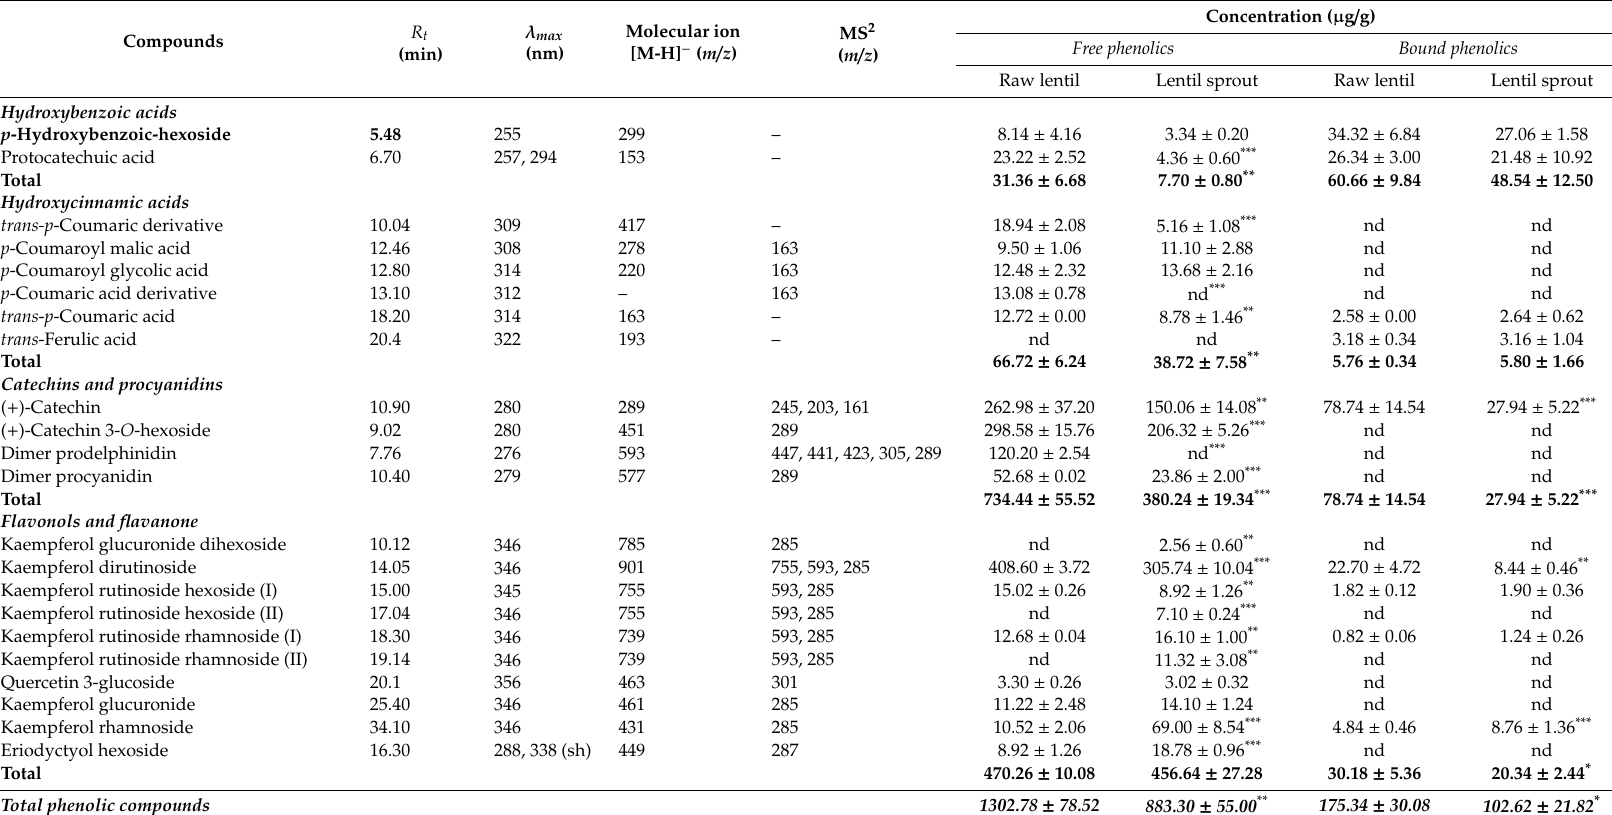
Table 3. Retention time ( R t ), wavelengths of maximum absorption in the visible region ( λ max ), mass spectral data, tentative identification, and quantification ( µ g / g dry matter) of free and bound phenolic compounds present in raw lentils and lentil